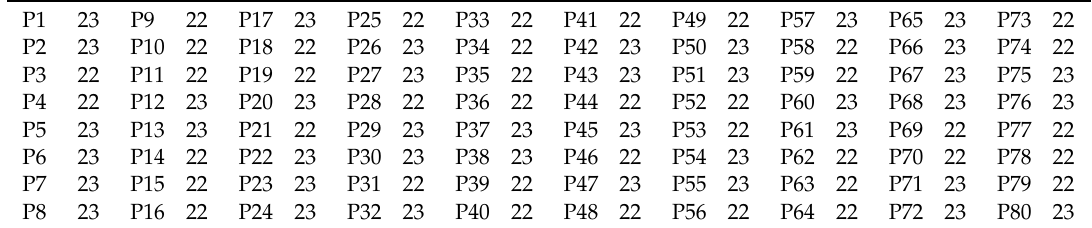
Table 6. Workloads of each personnel after scheduling is done with mathematical